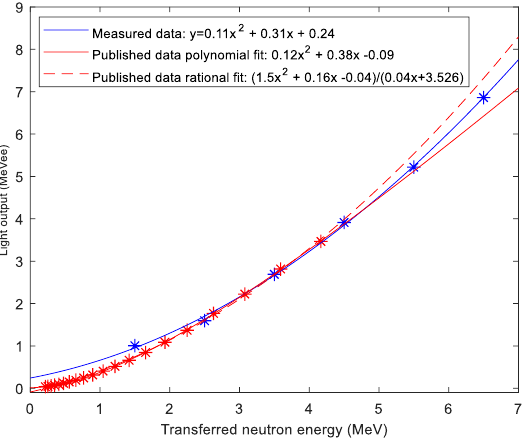
Fig. 5. Light functions for EJ-230 material from measured data and previously published data [8]. Second-degree polynomial and two-over-one rational fits were used to generate the light functions. Deviation between the two data